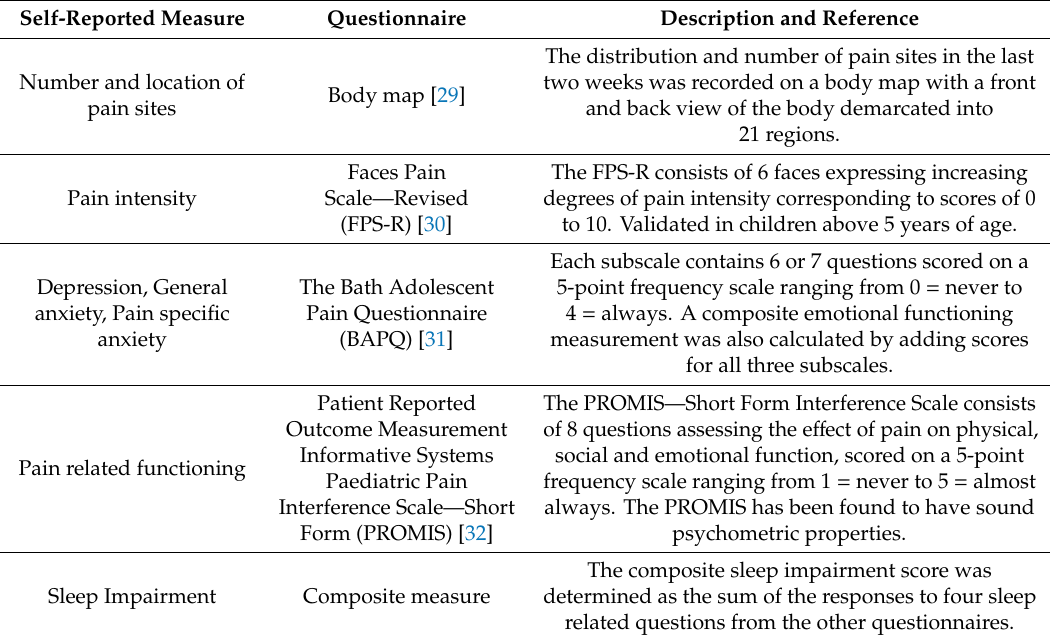
Table 1. Child and Parent Questionnaires.